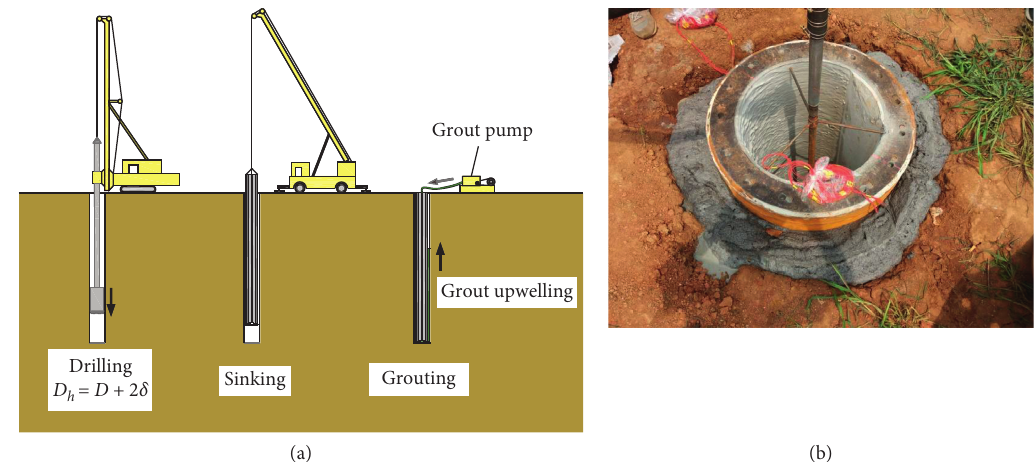
Figure 1: Drilled and Postgrouted Concrete Pipe Pile. (a) The construction processes. (b) Photo of the Drilled and Postgrouted Concrete Pipe Pile.